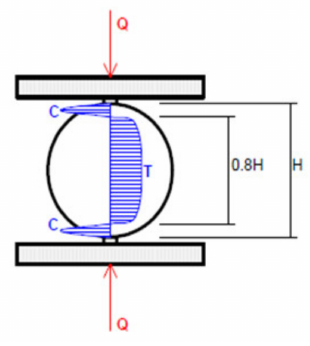
Figure 3. Brazilian Test [30].